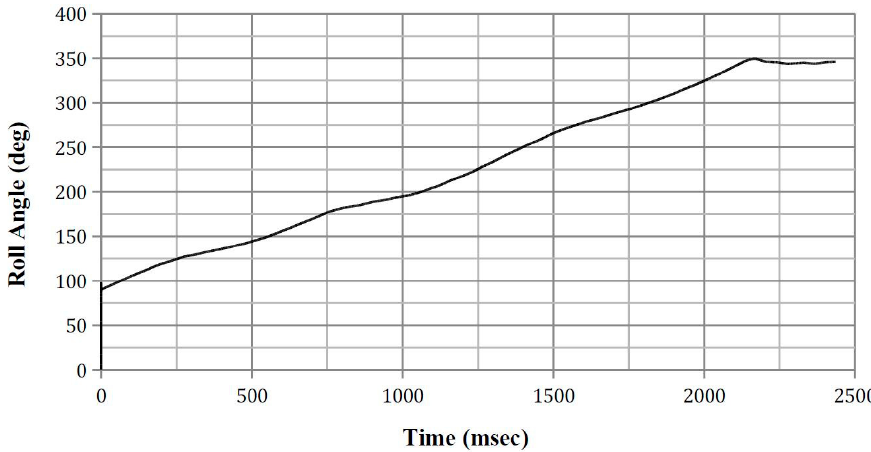
Figure A2. Vehicle centre of gravity roll rate (relative to the vehicle x-axis).